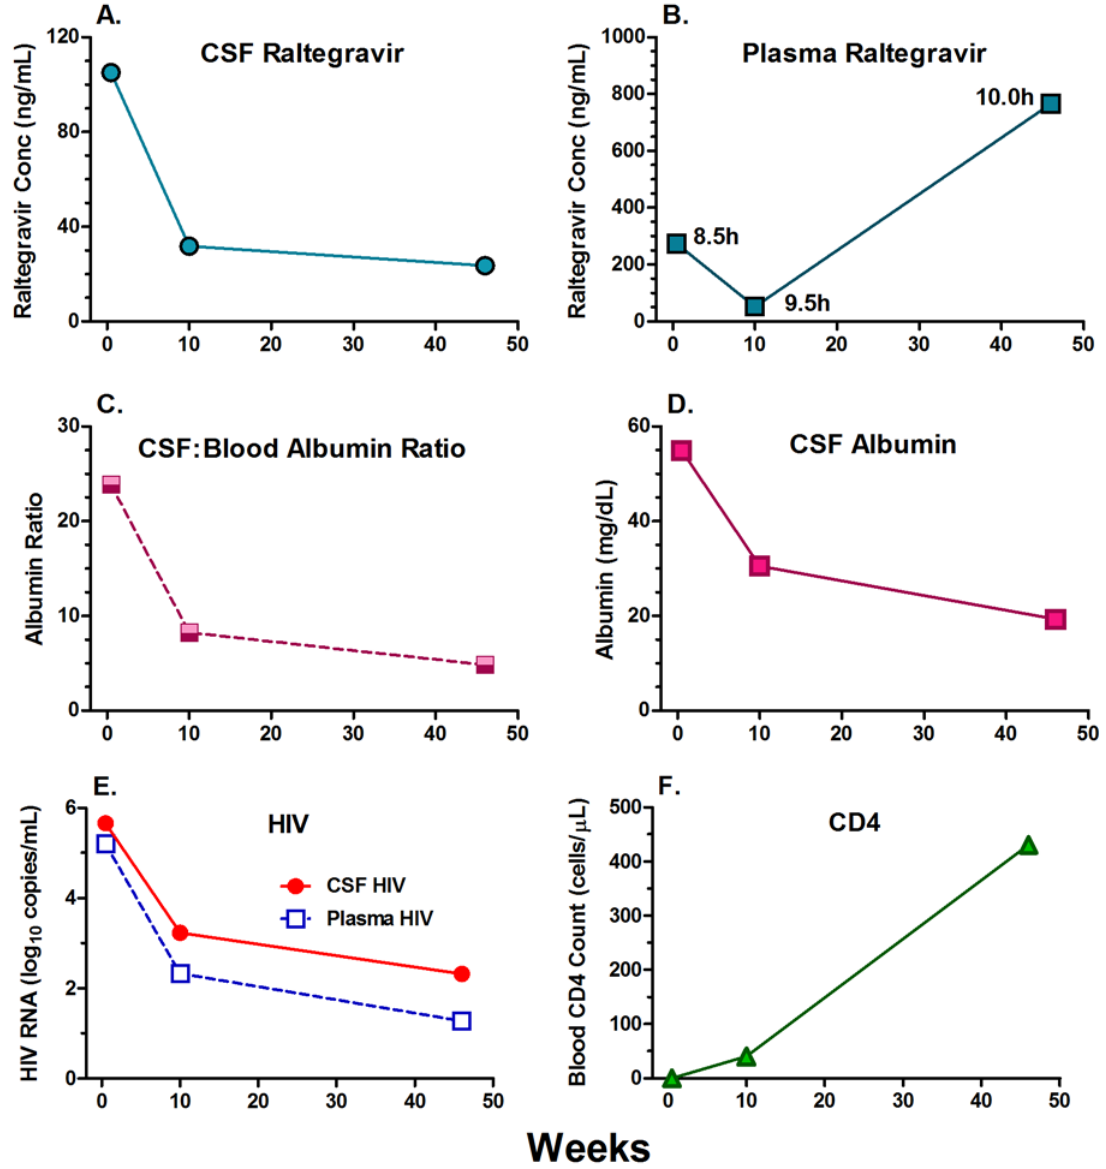
Figure 2. Longitudinal data from patient with three samples over the course of her illness (see text). A : CSF raltegravir concentrations fell as the patient recovered. B : Plasma raltegravir concentrations were variable despite similar times of sampling (shown in hours after dosing adjacent to symbols). C : Decline in the albumin ratio with recovery. D : Similar decline in the CSF albumin concentrations. E : HIV-1 RNA treatment response was parallel in plasma and CSF, with higher levels in the latter. F : Rapid blood CD4 + T cell